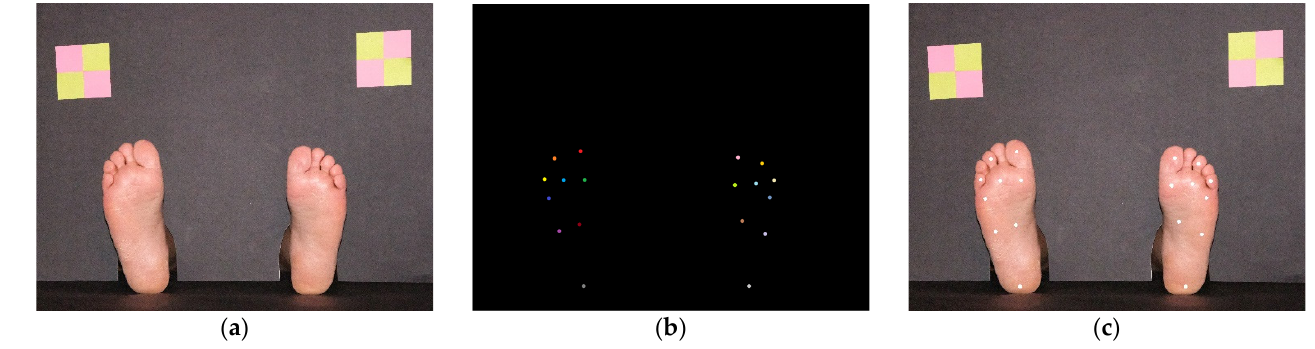
Figure 2. Image taken from the collected database, showing a female foot example. ( a ) Original image; ( b ) mask with 9 testing sites for each foot, manually annotated with different colors; ( c ) original image with superimposed testing sites mask painted in white.